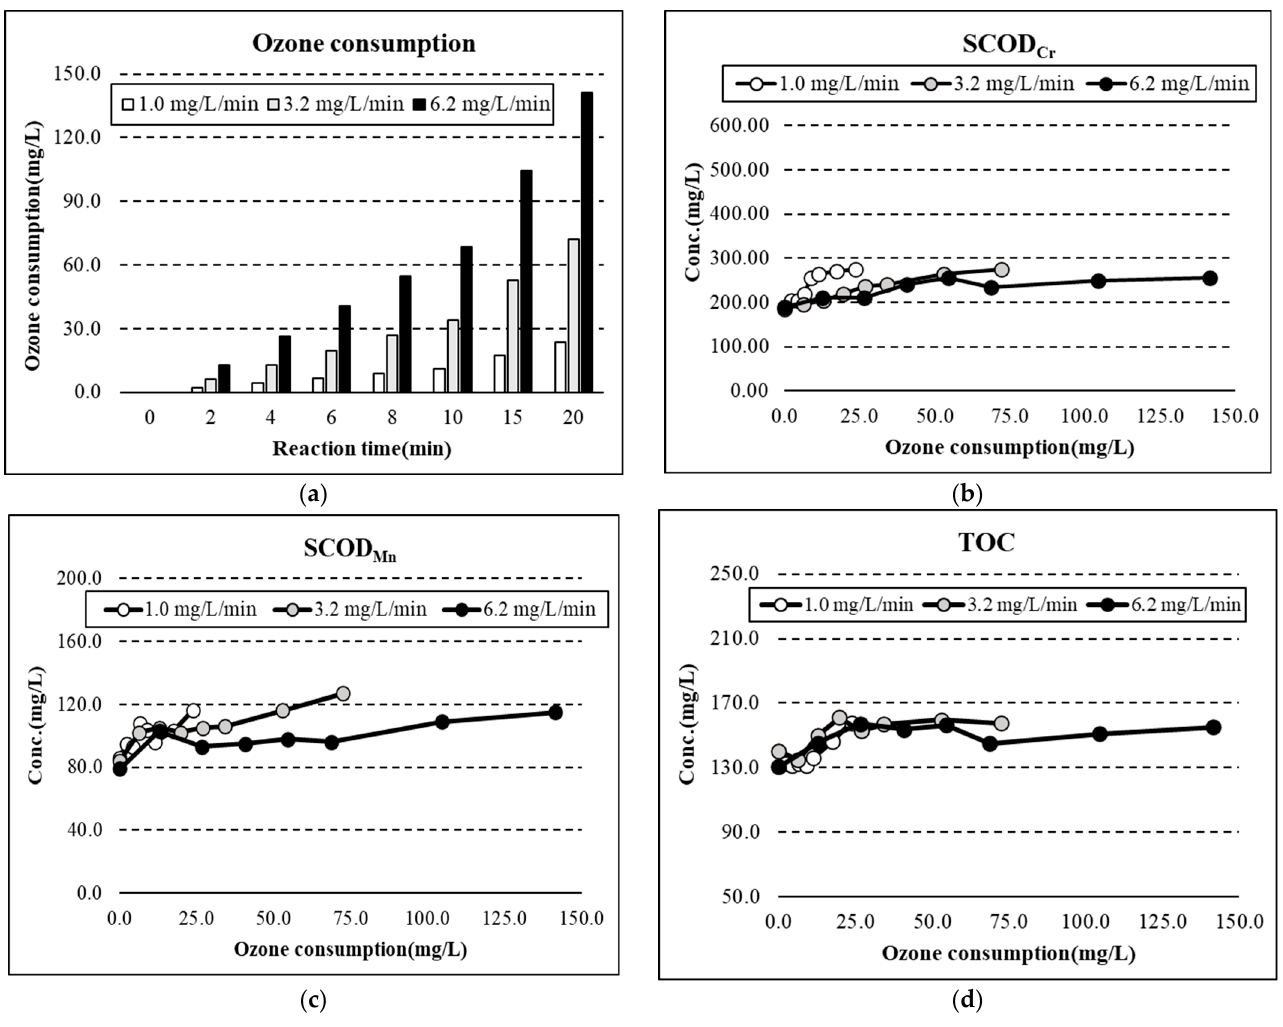
Figure 5. Effect of ( a ) ozone consumption and feed rate on ( b ) COD Cr , ( c ) COD Mn , and ( d ) TOC .